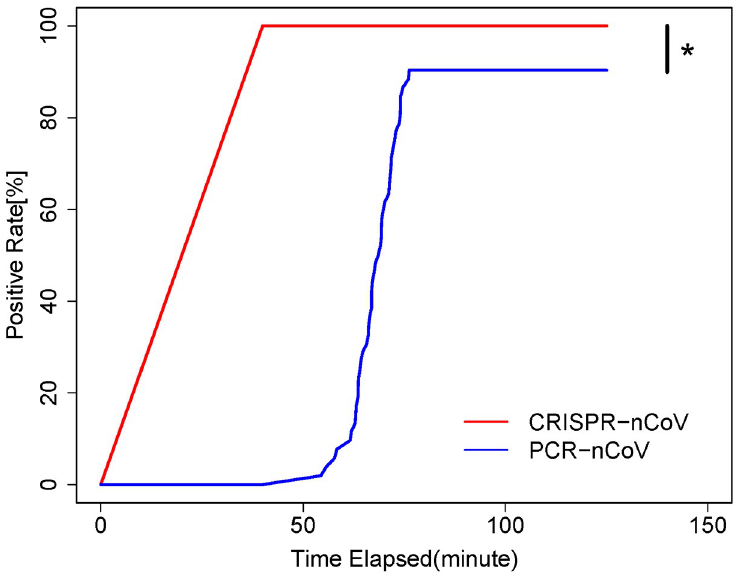
Fig 4. Kaplan–Meier curve of CRISPR-COVID positive rate by CRISPR and PCR. � Log-rank test, P <